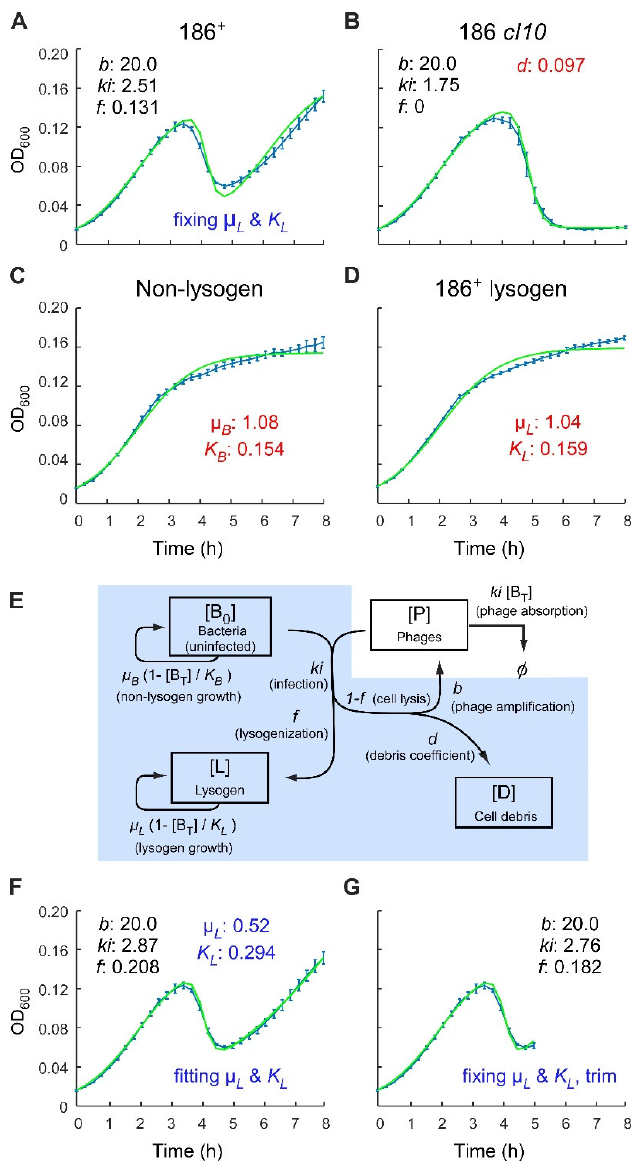
Figure 2. Analysis of 186 phage infection time courses with a simple lysogenisation model. ( A ) In- fection time course data (blue) and fit (green) following 186 + (wild type) phage infection. ( B ) The cell debris coefficient d was obtained by fitting 186 cI10 infection curve by setting lysogenisation frequency (f) to 0. The growth parameters (µ B , K B , µ L , and K L ) were fixed at the best fit parameters from fitting the nonlysogen ( C ) and 186 + lysogen ( D ) growth curves. ( E ) Schematic representation of the assumptions underlying the lysogenisation model. Populations that contribute to OD 600 read- ings are shaded in blue. ( F ) A better fit to the infection data was obtained when the lysogenic growth parameters were allowed to vary. In this case, the best fit lysogen growth rate was ~1/2 that from the growth curve fit (panel D ). ( G ) A good fit to the wild type 186 infection curve was also obtained with predetermined growth parameters (panels C , D ) when the infection curve is trimmed to two points beyond the trough minimum (~5 h). All infections were performed at MOA of 1.5 × 10 −4 . Error bars represent standard deviation, n = 6. For data fitting, three rounds of 50,000 iterations of fitting were performed, and the best fit from each round was plotted.